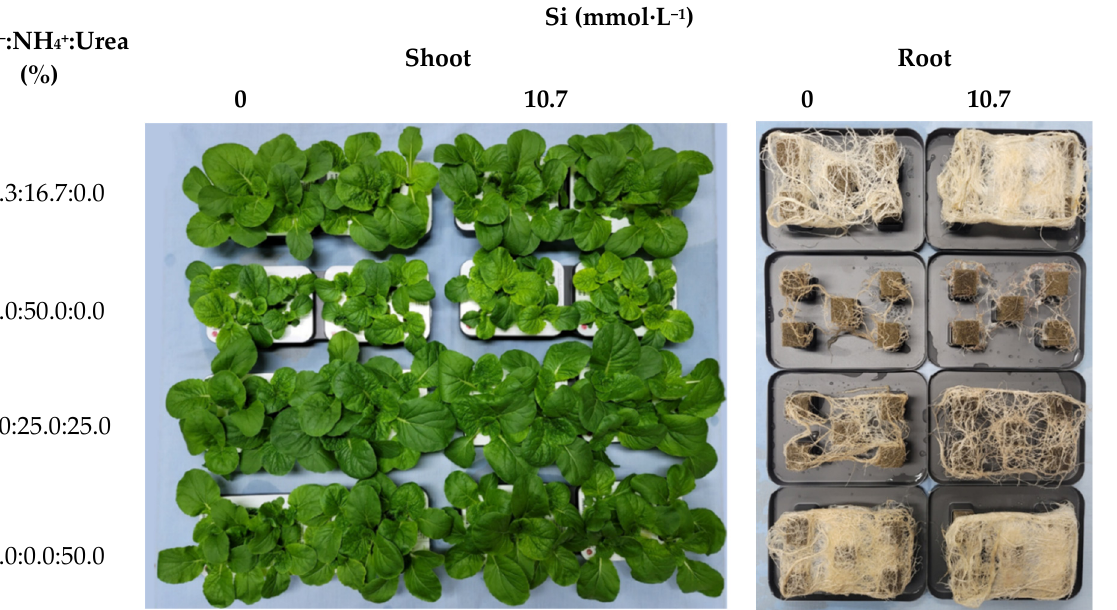
Figure 10. Shoot and root growth of Ssamchoo as affected by the nutrient solution 28 days after sowing in Experiment 3. The eight treatment solutions were four levels of NO 3 − /NH 4+ /urea ratio